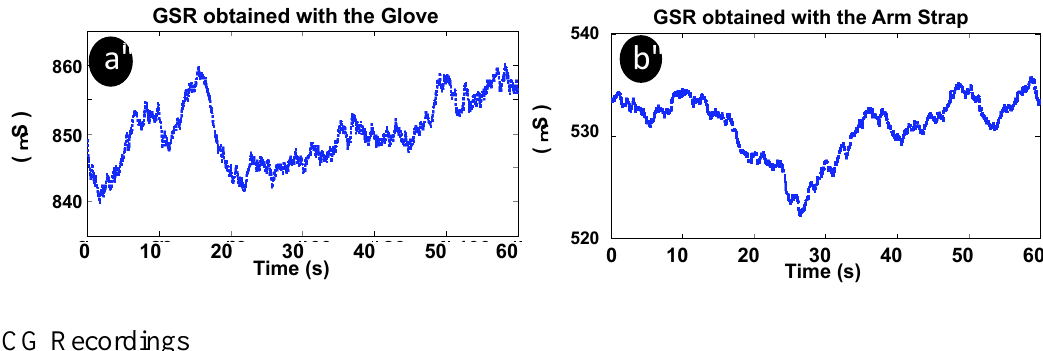
Figure 10. Galvanic skin response measurements. ( a ) Glove. ( b ) Upper arm